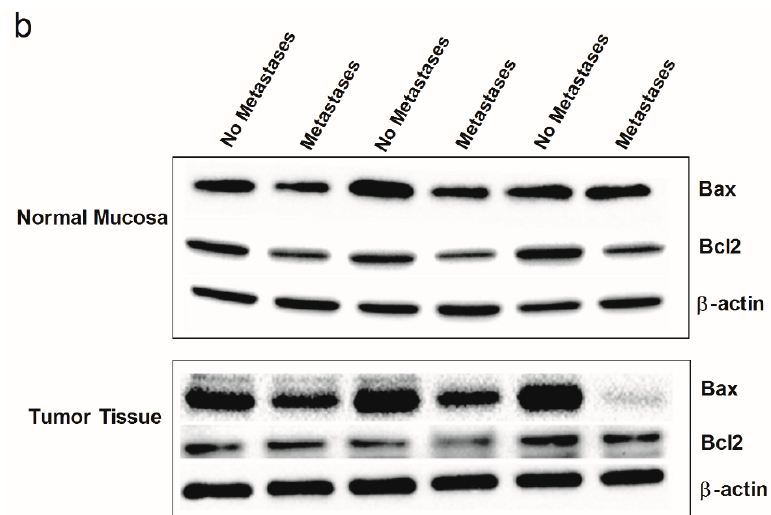
Figure 6. ( a ) Bax/Bcl2 ratio protein values detected in intestinal tissue of no metastases ( n = 29 patients) and with metastases patients ( n = 30 patients), in both normal mucosa and tumor tissue. ** p < 0.02, *** p < 0.001 indicate significant differences (one-way analysis of variance and Tukey’s multiple comparison test). ( b ) Representative Western blot bands of Bax, Bcl2 and β -actin proteins.